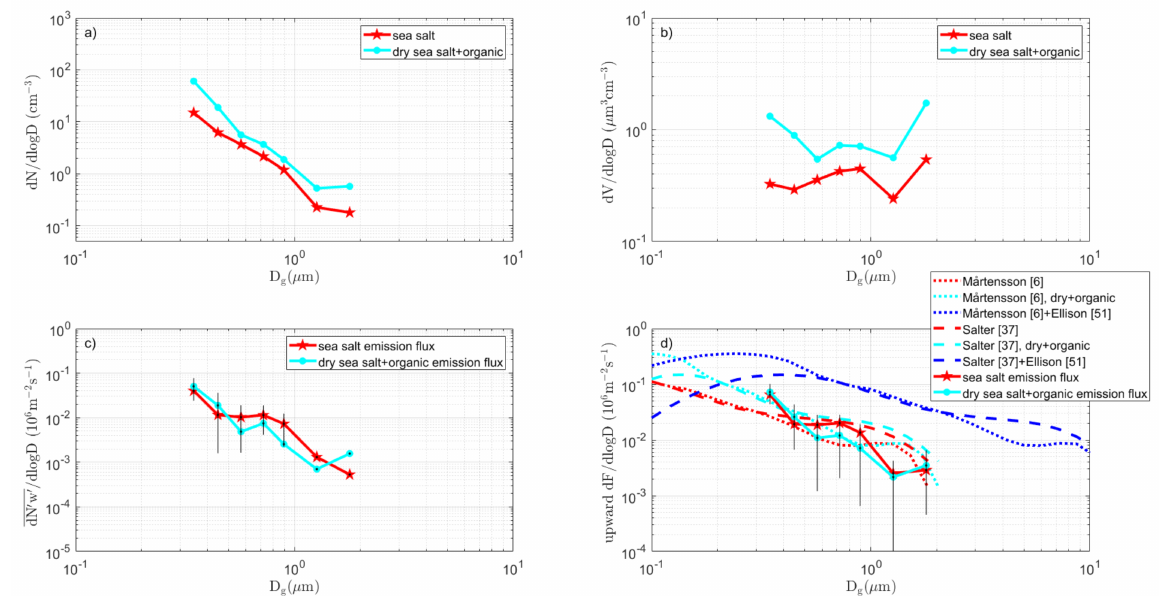
Figure 6. Average aerosol number and number flux size distributions in the 205–270 ◦ wind direction (coastal sector). Cyan curves with circles are unheated but dried aerosol particles, representative of the dry aerosol including all chemical components but water, while the red curves with stars are the non-volatile particles remaining after the air had been heated to 300 ◦ C. ( a ) Number size distributions. ( b ) Volume size distributions. ( c ) Number size flux distributions. ( d ) Number emission flux size distribution for the periods with a net upward positive flux. The full red curve is the measured average emission flux size distribution where the air first passed a thermodenuder at 300 ◦ C before passing the OPC, with the result that we should have measured the emission fluxes of a purely sea salt aerosol. The full cyan curve is the measured average emission flux size distribution where the air was not heated, but instead dried in a mixer before passing the OPC, with the result that we should have measured the emission flux of both the sea spray sea salt and the sea spray organic fraction, having only removed the water. Vertical bars are the average errors. Red dashed curve is the Salter et al. [37] sea spray sea salt source parameterization, adapted to the local salinity (on average 7 ppt). Similarly, red dotted curve is the Mårtensson sea spray source parameterization [6] adapted for the local salinity. Blue dashed curve is intended to estimate the original sea spray droplets according to the combination of the Salter et al. [37] and Ellison et al. [50] models. The cyan dashed curve is the resulting dried sea salt + organic sea spray size spectra after removing all water from the blue dashed curve. The blue dotted curve is likewise an estimate of the original wet droplets according to the combined Mårtensson [6] and Ellison [50] models, while the cyan dotted curve is the resulting dried sea salt + organic aerosol size spectra from the blue dotted